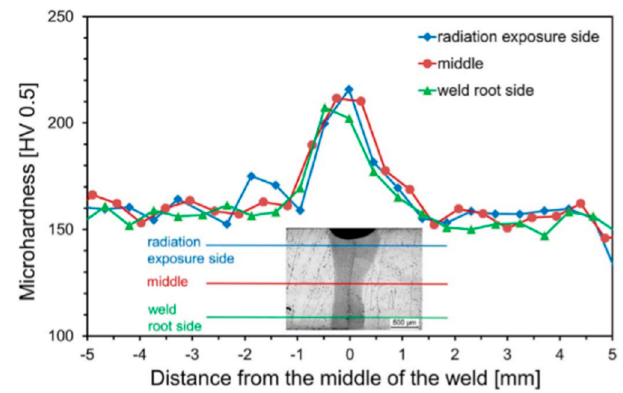
Figure 2. Microhardness profile of a laser beam welded joint (Reproduced from [53], with permission from Elsevier, 2018).